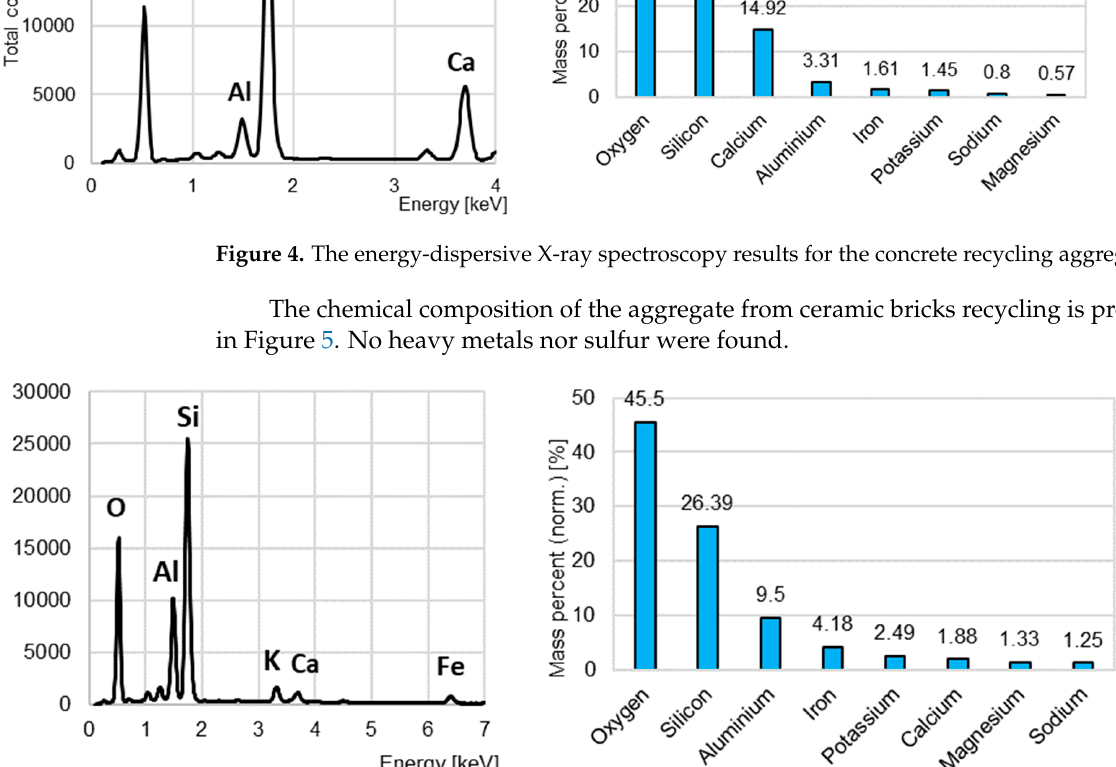
Figure 6. The energy-dispersive X-ray spectroscopy results for the burnt sewage sludge aggregate. The investigations of the ashes and slags from the thermal conversion of the sewage sludges are focused on their potential application in the production of building materials, such as glass ceramics [42–44], bricks [44,45], and cement mortar and concrete [46–48] . These additives are used as direct substitutes for clay, cement, or sand [44,49–52]. The EDS analysis showed no chlorides in the tested specimens . In the case of burnt sewage sludges, other researchers also confirm the lack of chlorides [48,53]. According to the Polish regu- lations [54] , ashes and slags created during the sewage sludge burning can be used for preparing the mixes for construction purposes, excluding, however, the use in buildings destined for the permanent residence of people or animals and the buildings with food processing . They also do not fulfill standard requirements for concrete and cement [55,56]. 3.2. Consistency and Apparent Density of Concrete Mixes The results of consistency testing are presented in Figure 7. The biggest worsening of consistency was caused by the aggregate from the sewage sludge; for the CSS50 mix, it was more than 50% in relation to the reference mix CR0. The reason for this consistency